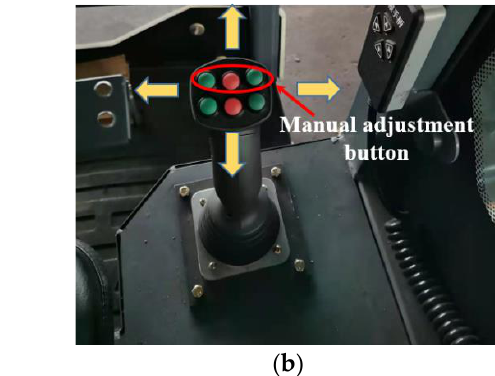
Figure 5. Operation platform: ( a ) Auto-manual switch, ( b ) Control handle.